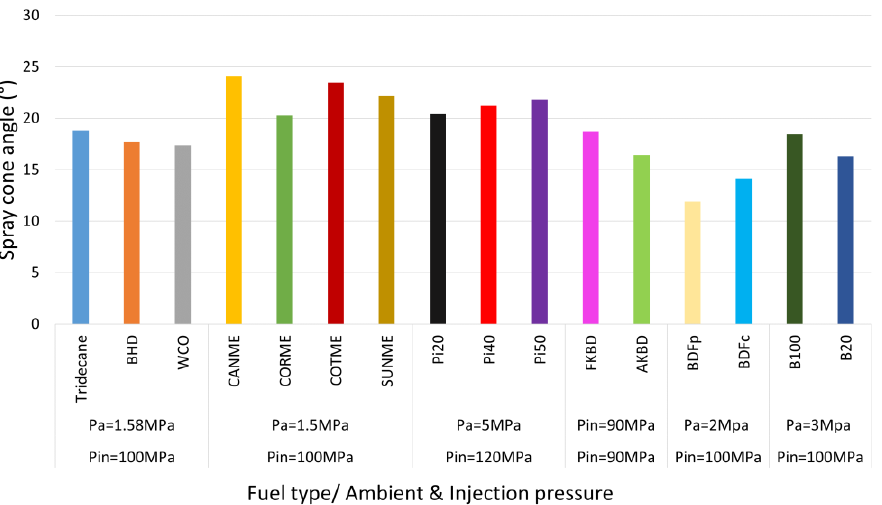
Figure 11. PL for biodiesel blends at various injection & ambient pressure [47,87,92,94,98,99].